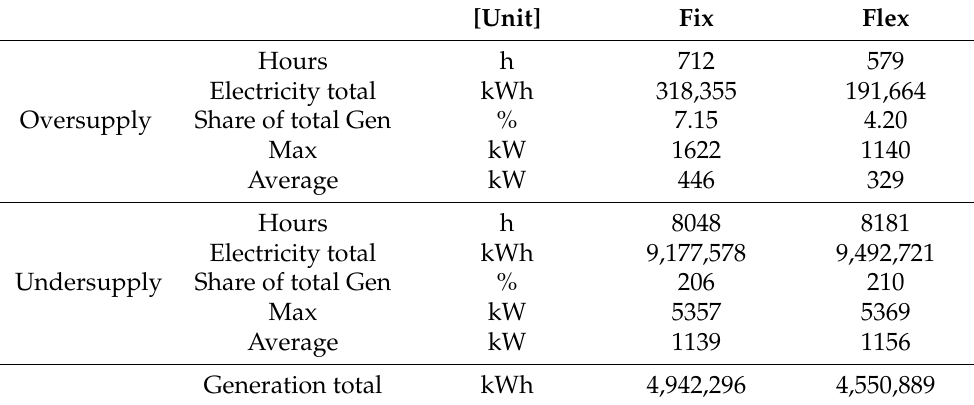
Table 7. Market results of product “Green Regional”.